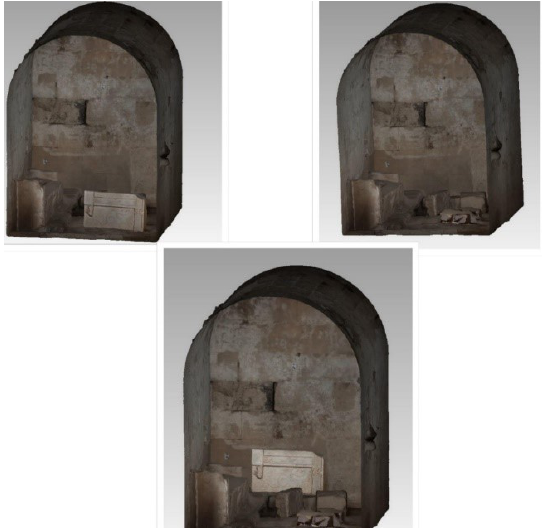
Figure 13: The virtual restoration of the burial bed of the